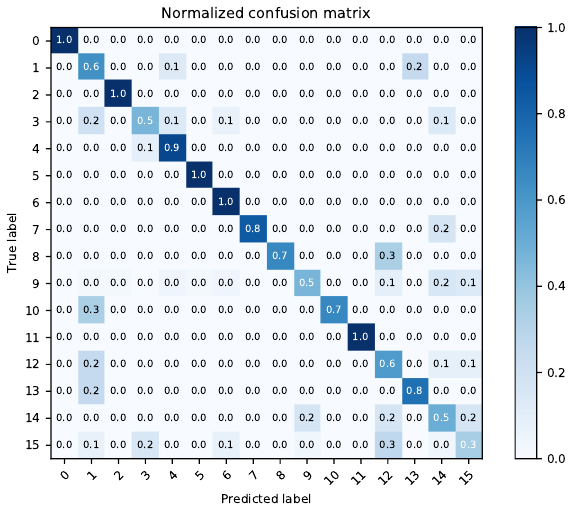
Figure 5. Confusion matrix of Ore Classification